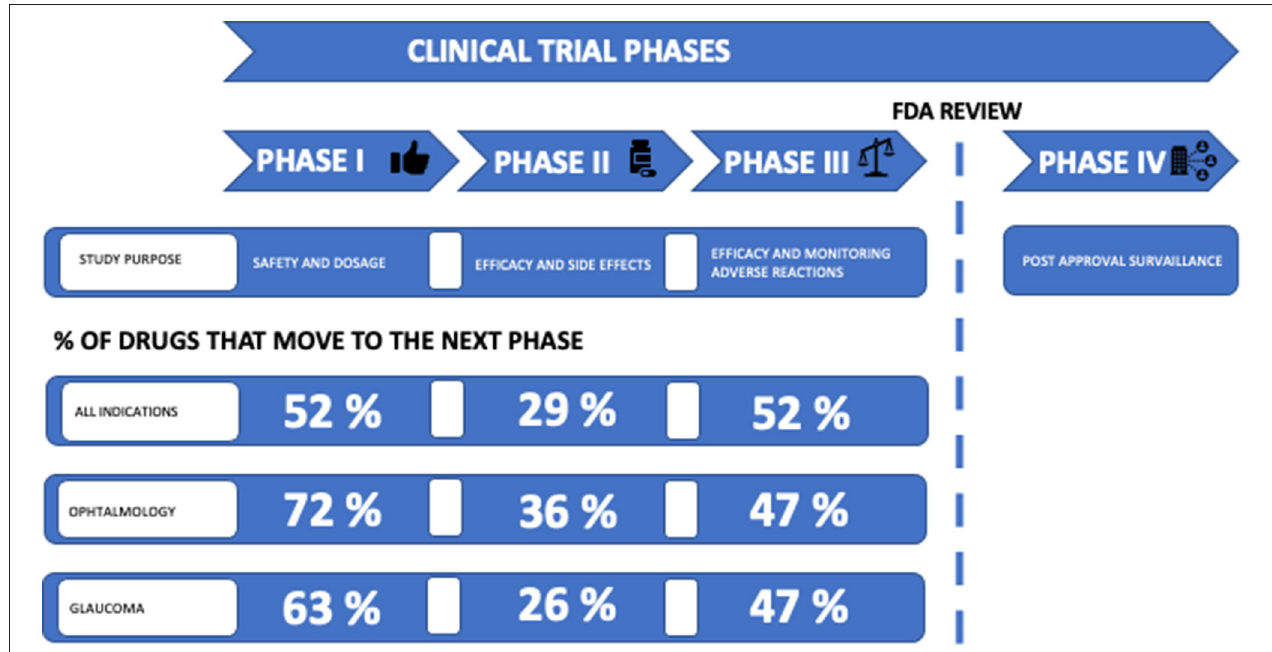
FIGURE 5 | Clinical development success rates. Clinical trial phases are linked to study purpose; phase I studies investigate safety and dosage, phase II studies investigate efficacy and side effects, phase III studies investigate efficacy and monitoring of adverse events, and phase IV studies investigate post-approval surveillance. Before entering phase IV, an FDA review is required. The percentage of drugs that proceed to next phase is listed. Success rates from Table 3 are listed as “Glaucoma” and compared with success rates for ophthalmology and for all indications in the period 2011–2021 in general. Source: BIO (Biotechnology, Innovation, Organization)